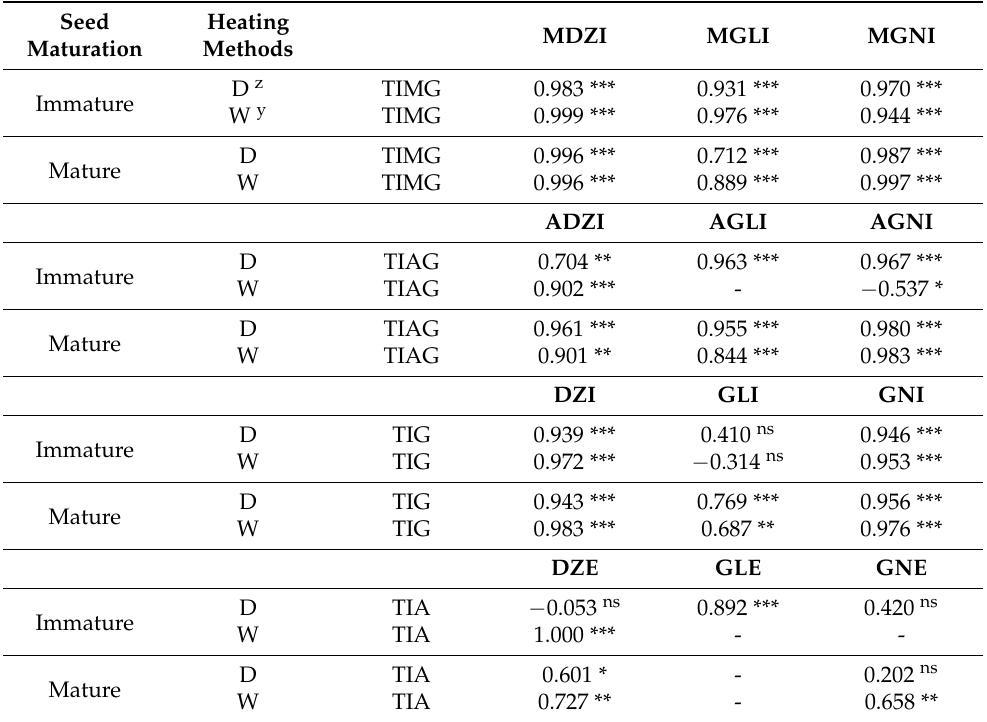
Table 4. Correlation coefficients between isoflavone forms and individual isoflavones in thermally treated